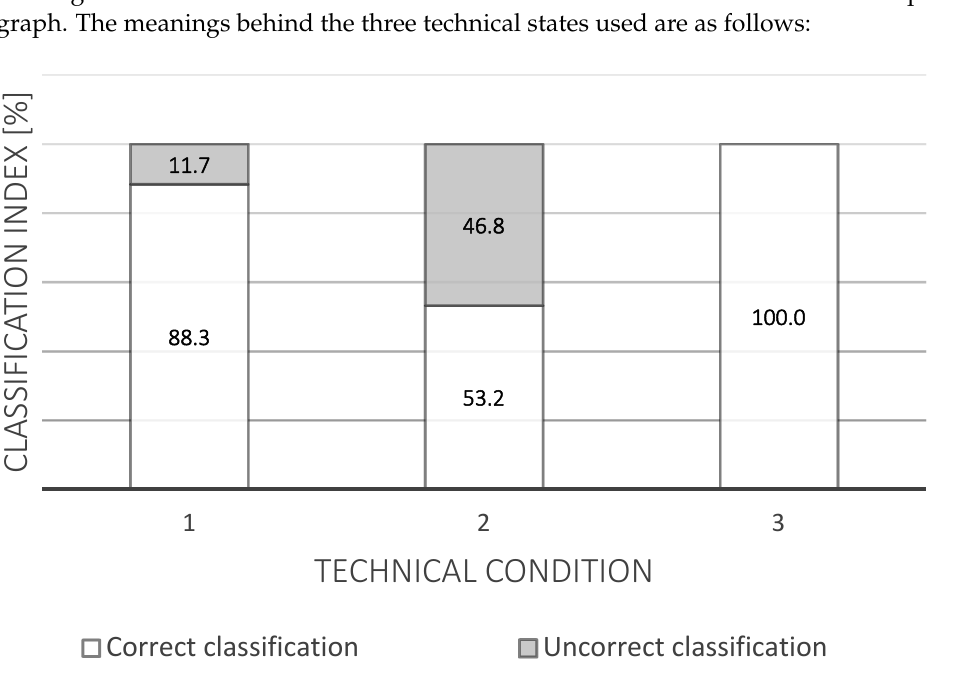
Figure 9. Correctness of classification of the technical condition of a pantograph.